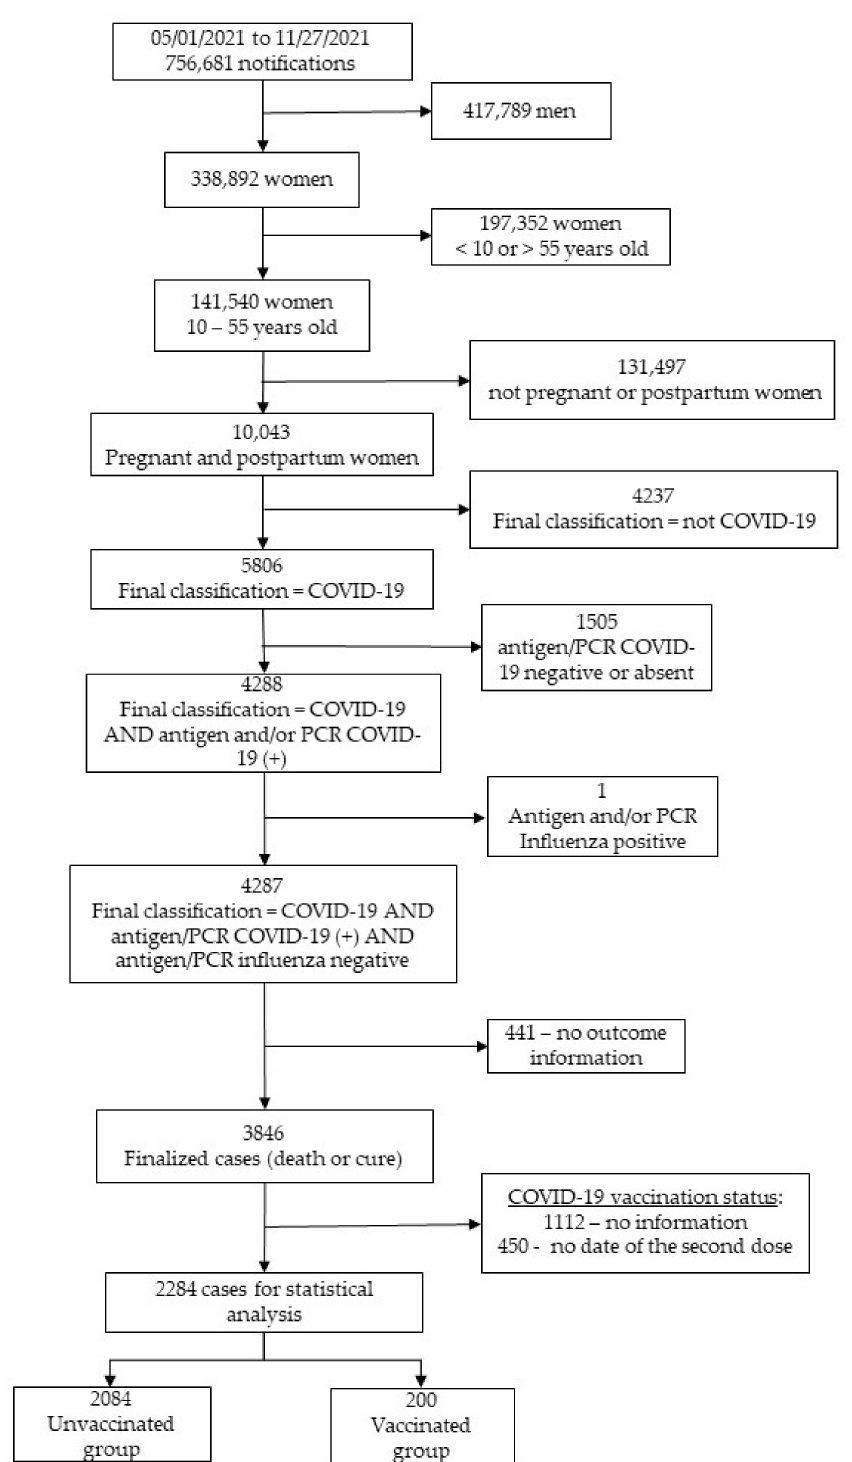
Figure 1. Participant flowchart. COVD-19, coronavirus disease 2019; PCR—polymerase chain